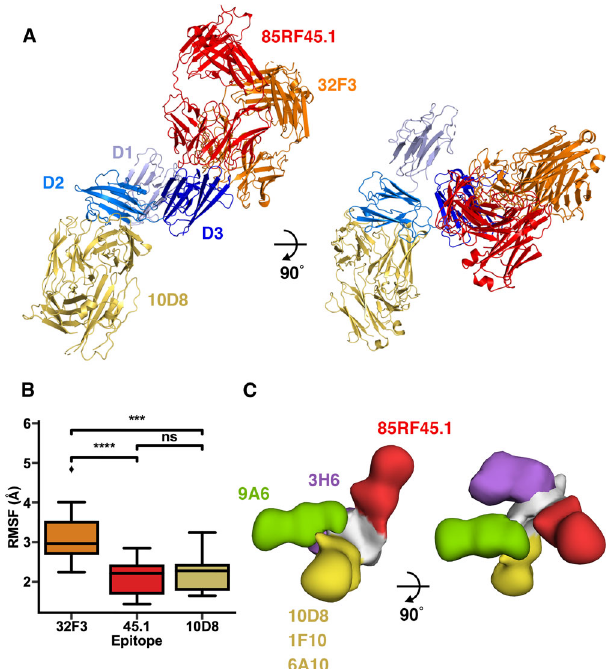
Fig. 4 | distribution of epitopes for transmission-blocking antibodies across Pfs48/45. A The structure of Pfs48/45 bound to 10D8 is used as a template, and combinedwithstructuresoftheD3domainofPfs48/45boundtoeither85RF45.1or 32F3 to generate a model, showing the relative locations of the three antibody epitopes. B Ameasureof the fl exibility of the residueswhich formthe epitopes for 32F3, 85RF45.1 and 10D8, as derived from molecular dynamics simulations. Each epitopewas analysed in all 15 replicates and signi fi cancelevels are based on a two- sided Mann – Whitney U tests where *** indicates p <0.0005 and **** indicates p <0.00005. The box bounds are interquartile ranges, and the lines within boxes arethemedianvalues.Whiskersextendto1.5-foldtheinterquartilerange.For32F3 vs 85RF45.1 p =0.00008; for 32F3 vs 10D8 p =0.00031; for 10D8 vs 85RF45.1 p =0.58974. C A composite model, derived from negative-stain electron micro- scopy structures. In each case, the complexes contained Pfs48/45 bound to 85RF45.1, together with either 9A6, 3H6, 10D8, 1F10 and 6A10. These were imaged by negative stain electron microscopy, and models were fi tting into the resultant envelopes. These models were used to align the envelopes, allowing us to derive a composite model, showing the location for the fi ve